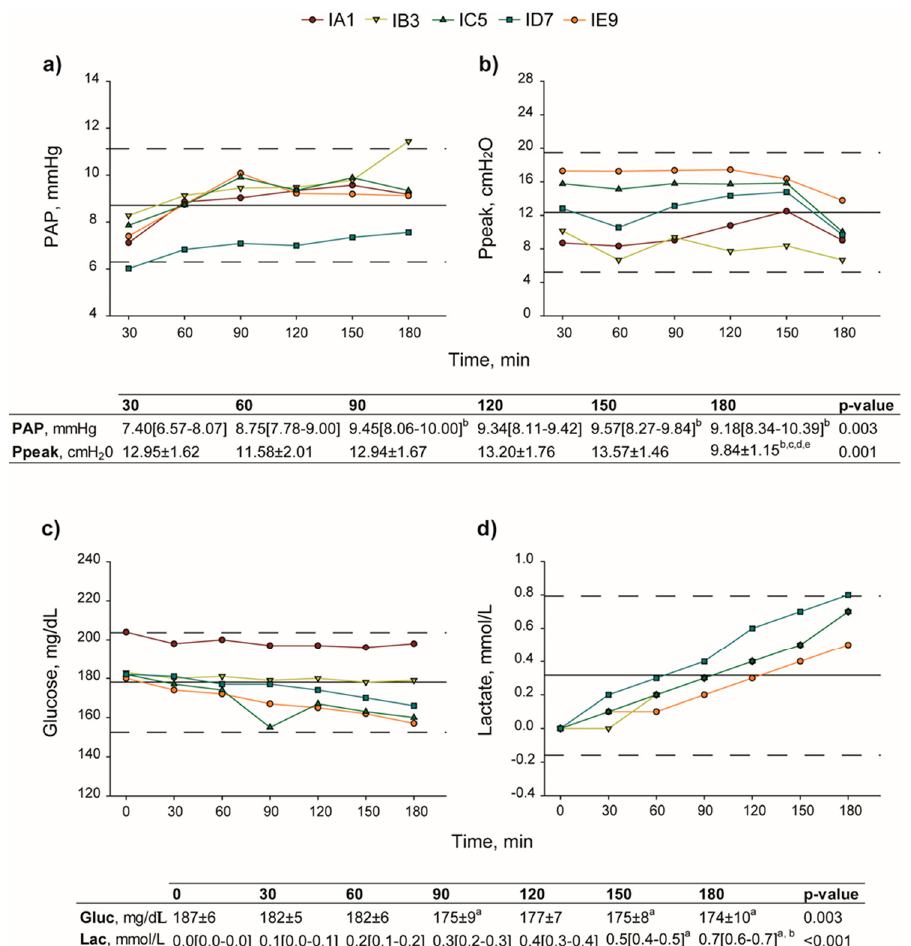
Figure 2. Evaluation of lung function during EVLP procedure. ( a ) PAP, significantly increased ( p < 0.003), and ( b ) Ppeak, decreased following recruitment maneuvers ( p < 0.001). ( c ) Concentration of glucose (from 187 ± 6 mg/dL at 0 min to 174 ± 10 at 180 min, p = 0.003) and ( d ) lactate (0.6–0.7 mmol/L at 180 min, p < 0.001) significantly changed during reperfusion. PAP, pulmonary artery pressure; Ppeak, peak inspiratory pressure. One-way repeated measures ANOVA; Tukey’s multiple comparison test. p < 0.05: a = vs. 0 min; b = vs. 30 min; c = vs. 90 min; d = vs. 120 min; e = vs. 150 min.